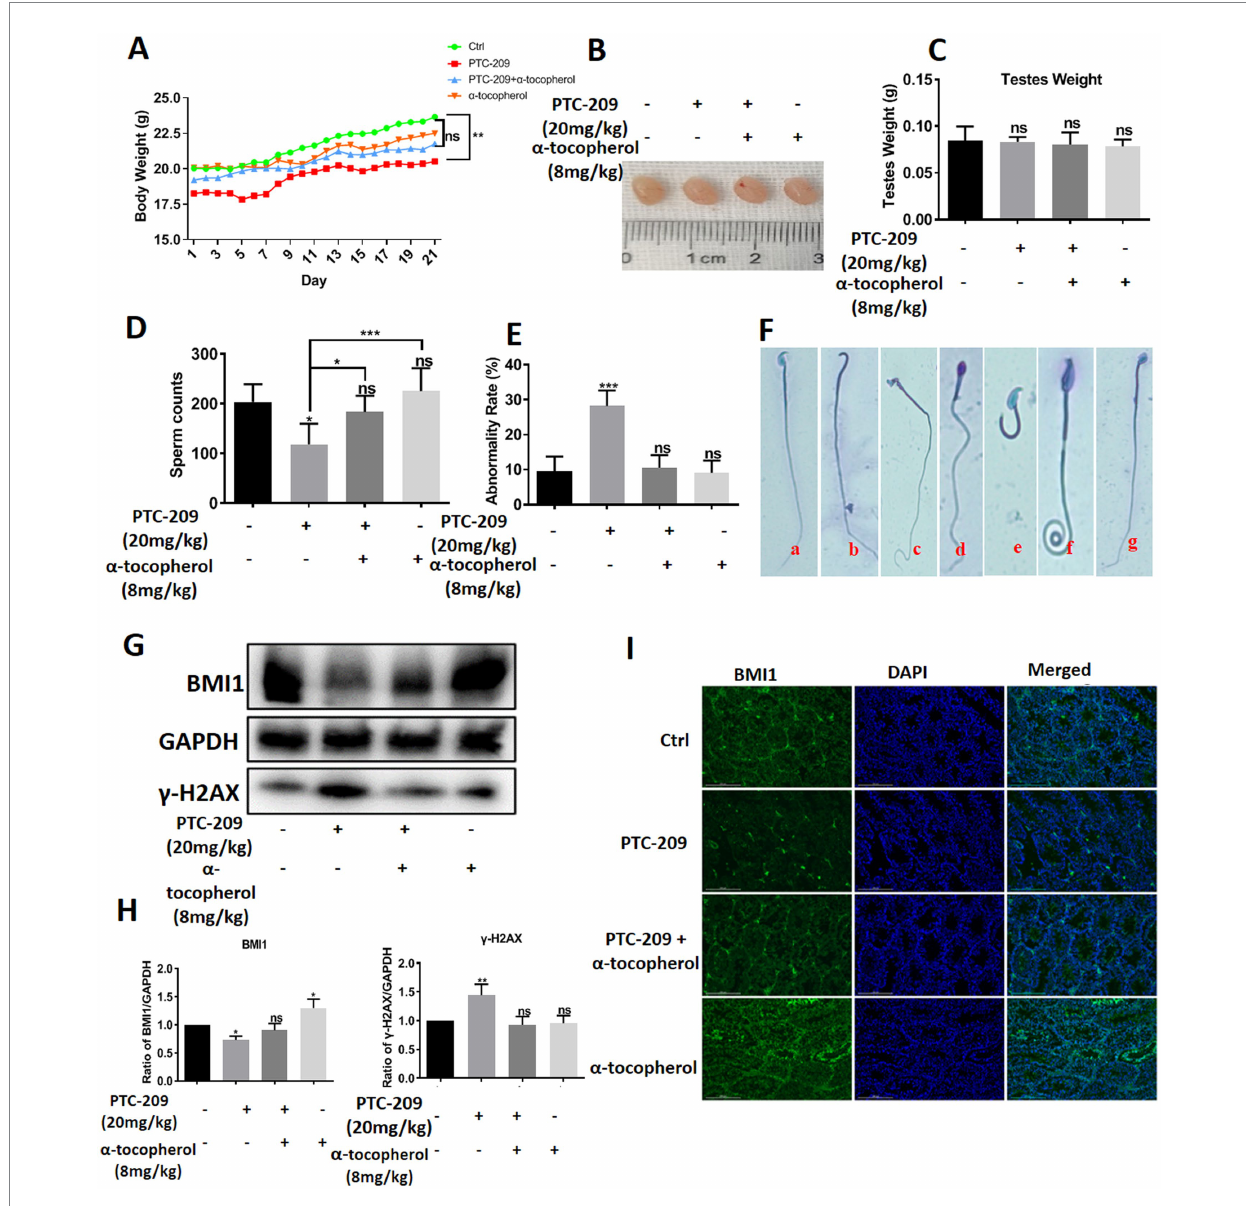
α -tocopherol restored the mouse spermatid malformations caused by BMI1